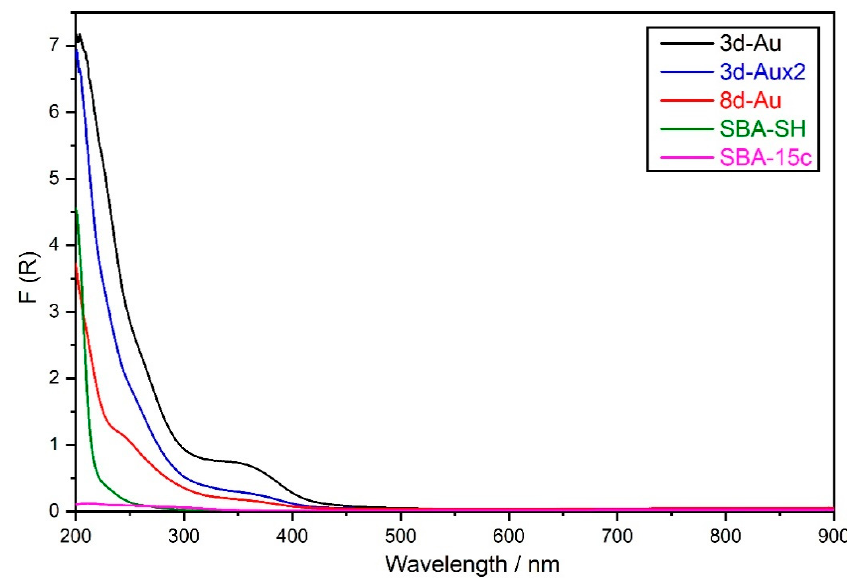
Figure 4. UV-vis spectra of the samples.